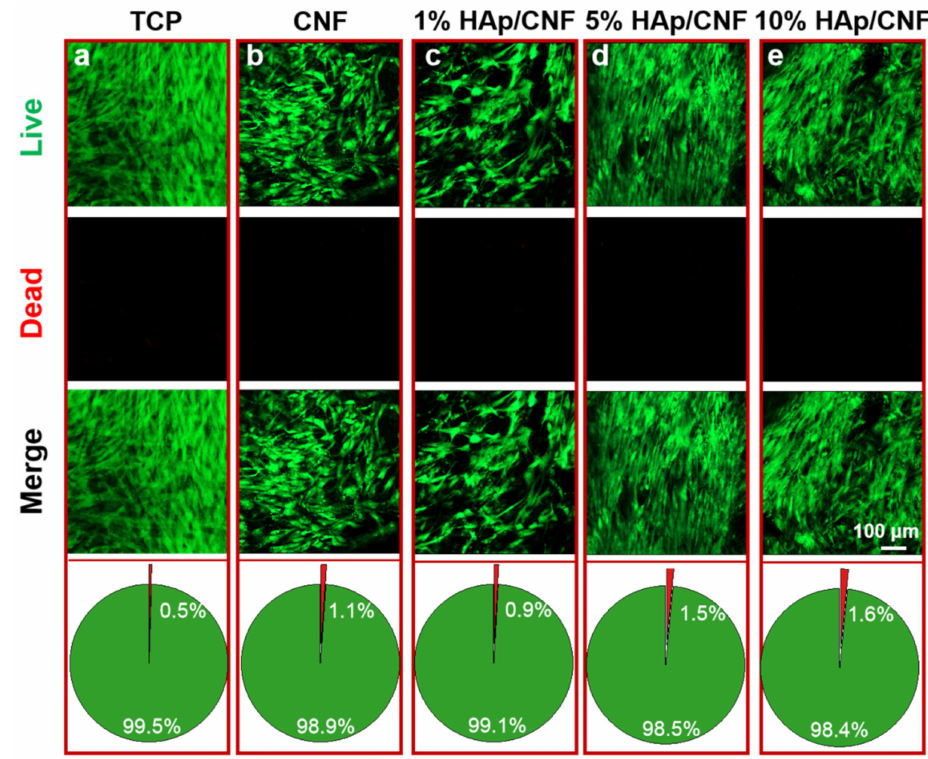
Figure 2. Live/dead cell staining and analysis of the proportion of live and dead cells cultured on various materials after 2 days. ( a ) TCP: tissue culture plates. ( b ) CNF membranes. ( c ) 1% HAp/CNF membranes. ( d ) 5% HAp/CNF membranes. ( e ) 10% HAp/CNF membranes. Live cells were stained green, and the dead cells were stained